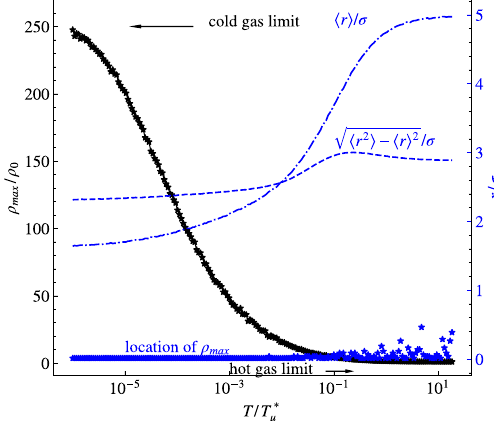
FIG. 23. Variation of the radial density distribution of MDM molecules with temperature T=T (cid:3) μ . Shown are the density enhancement due to the pinch in the beam field (black markers, left axis), the radial location of the maximum (blue markers, right axis), the average radial position of molecules (dash-dotted blue line), and the rms value of the radial position (dashed blue line).